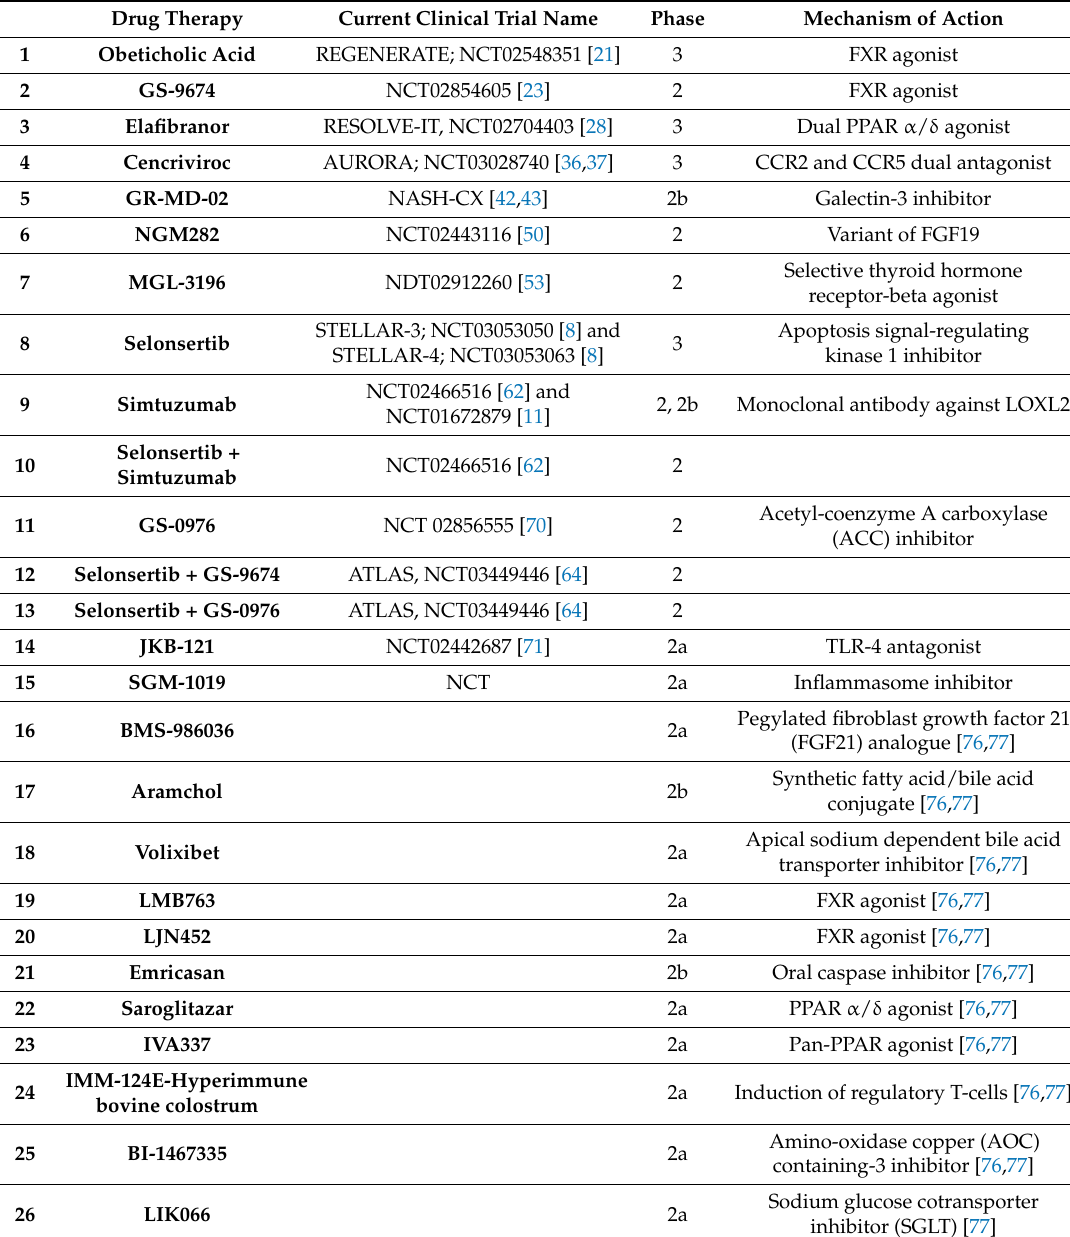
Table 1. Emerging drugs in the treatment of nonalcoholic fatty liver disease (NAFLD). FXR: farnesoid X receptor; PPAR: peroxisome proliferator-activated receptor; CCR: C-C chemokine receptor; FGF: fibroblast growth factor; TLR: toll-like receptor; NCT: National Clinical